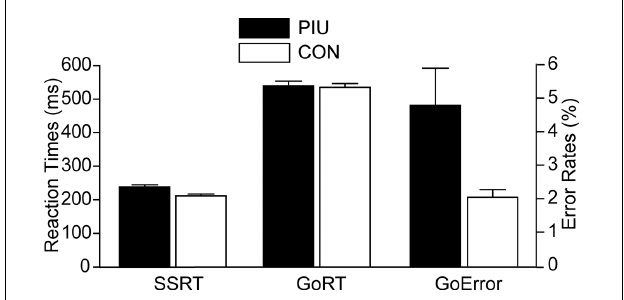
FIGURE 2 | Stop signal task performance group means and 95% confidence intervals for three measures: stop signal reaction time (SSRT; an index of response inhibition), reaction time in go trials (GoRT), and error rates in go trials (GoError). SSRTs and RTs were in ms (left y -axis), whereas error rates were in percentages (right y -axis). PIU individuals had significantly longer SSRTs and higher error rates than the control group, but they did not significantly differ in RTs